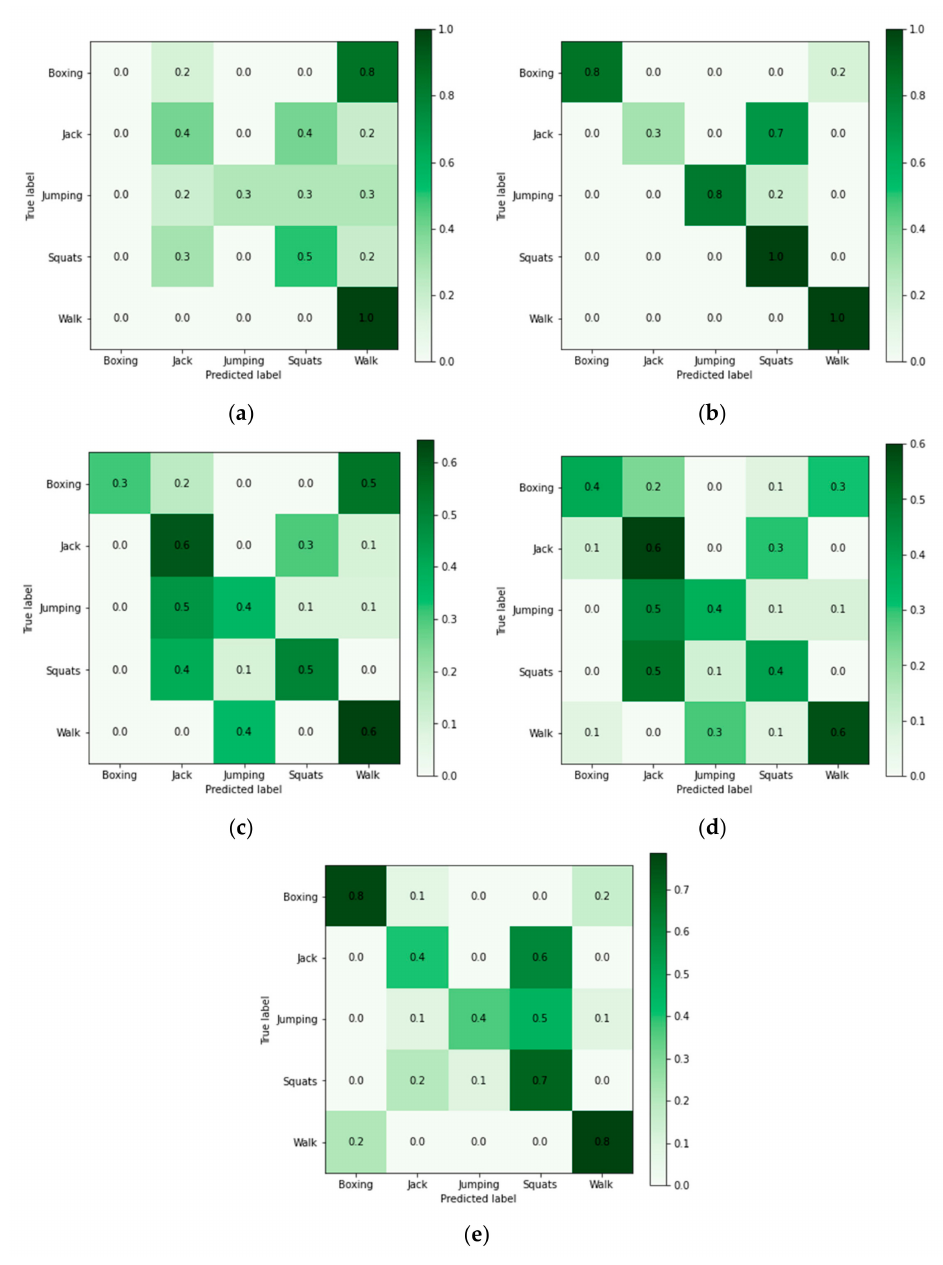
Figure 7. Confusion matrix of models used in the ablation study. ( a ) Confusion matrix of GCN using 19 joints. ( b ) Confusion matrix of ST-GCN using 25 joints. ( c ) Confusion matrix of GCN using 25 joints. ( d ) Confusion matrix of GCN using raw data. ( e ) Confusion matrix of ST-GCN using raw